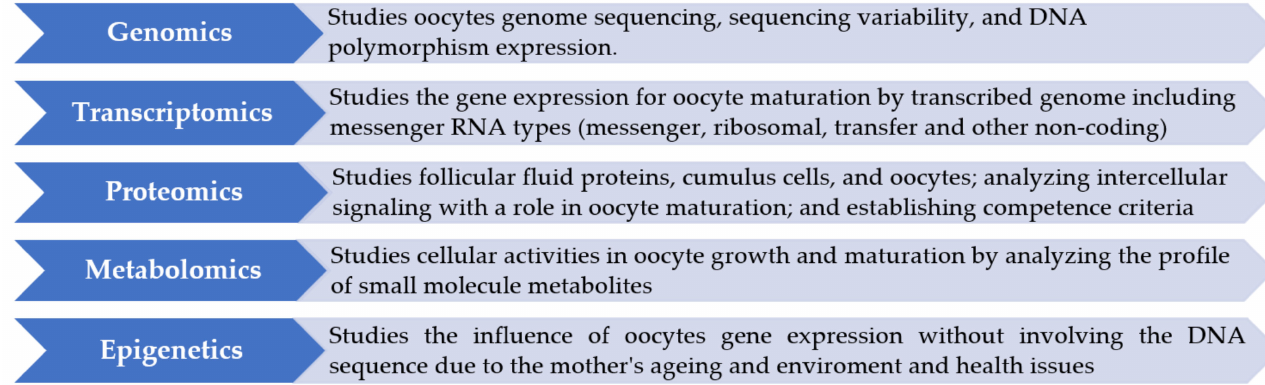
Figure 5. The OMICS technologies used for oocytes